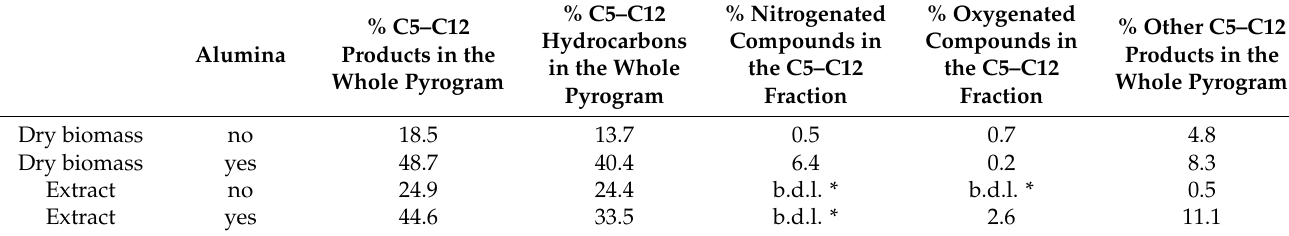
Table 2. Pyrolysis at 600 ◦ C of Desmodesmus sp. microalgae and of its n-hexane extract in presence or absence of alumina catalyst: semiquantitative estimation of the C5–C12 fraction in the whole pyrogram, of the hydrocarbon fraction and of the oxygenated and nitrogenated products, and the sum of oxygenated, nitrogenated and unidentified groups in the complete